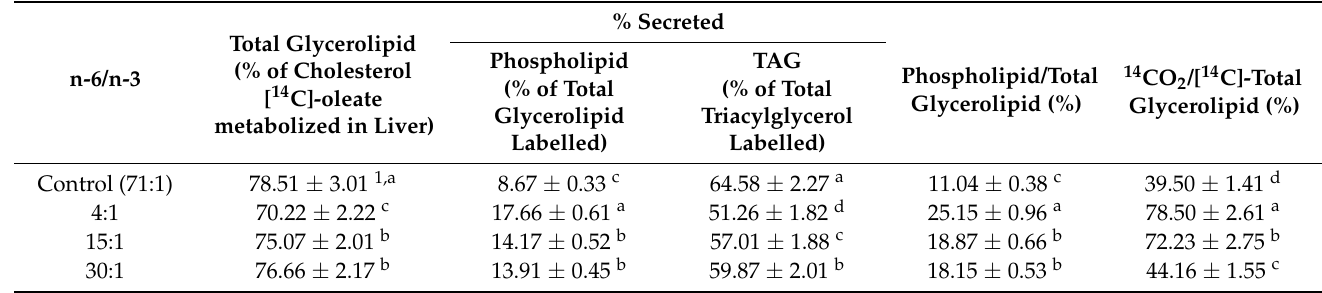
Table 3. Metabolic distribution of glycerolipid to blood from livers in obese animal biomodel rat-fed diets containing different